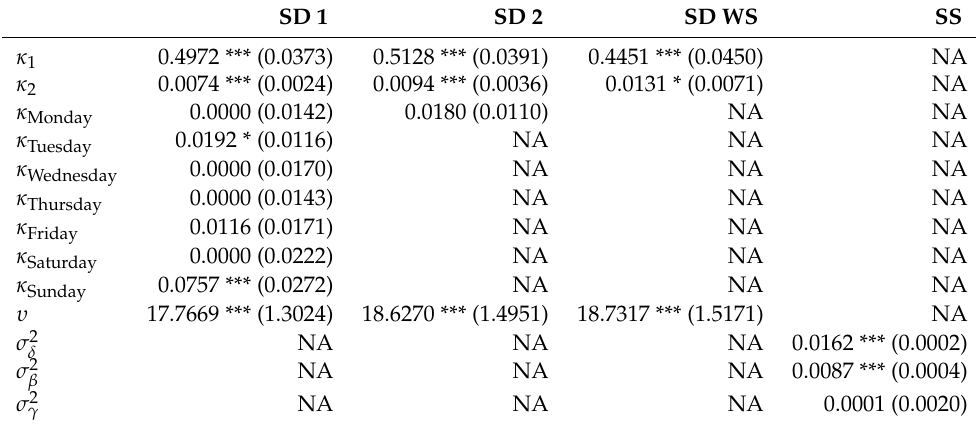
Table A6. Parameter estimates for